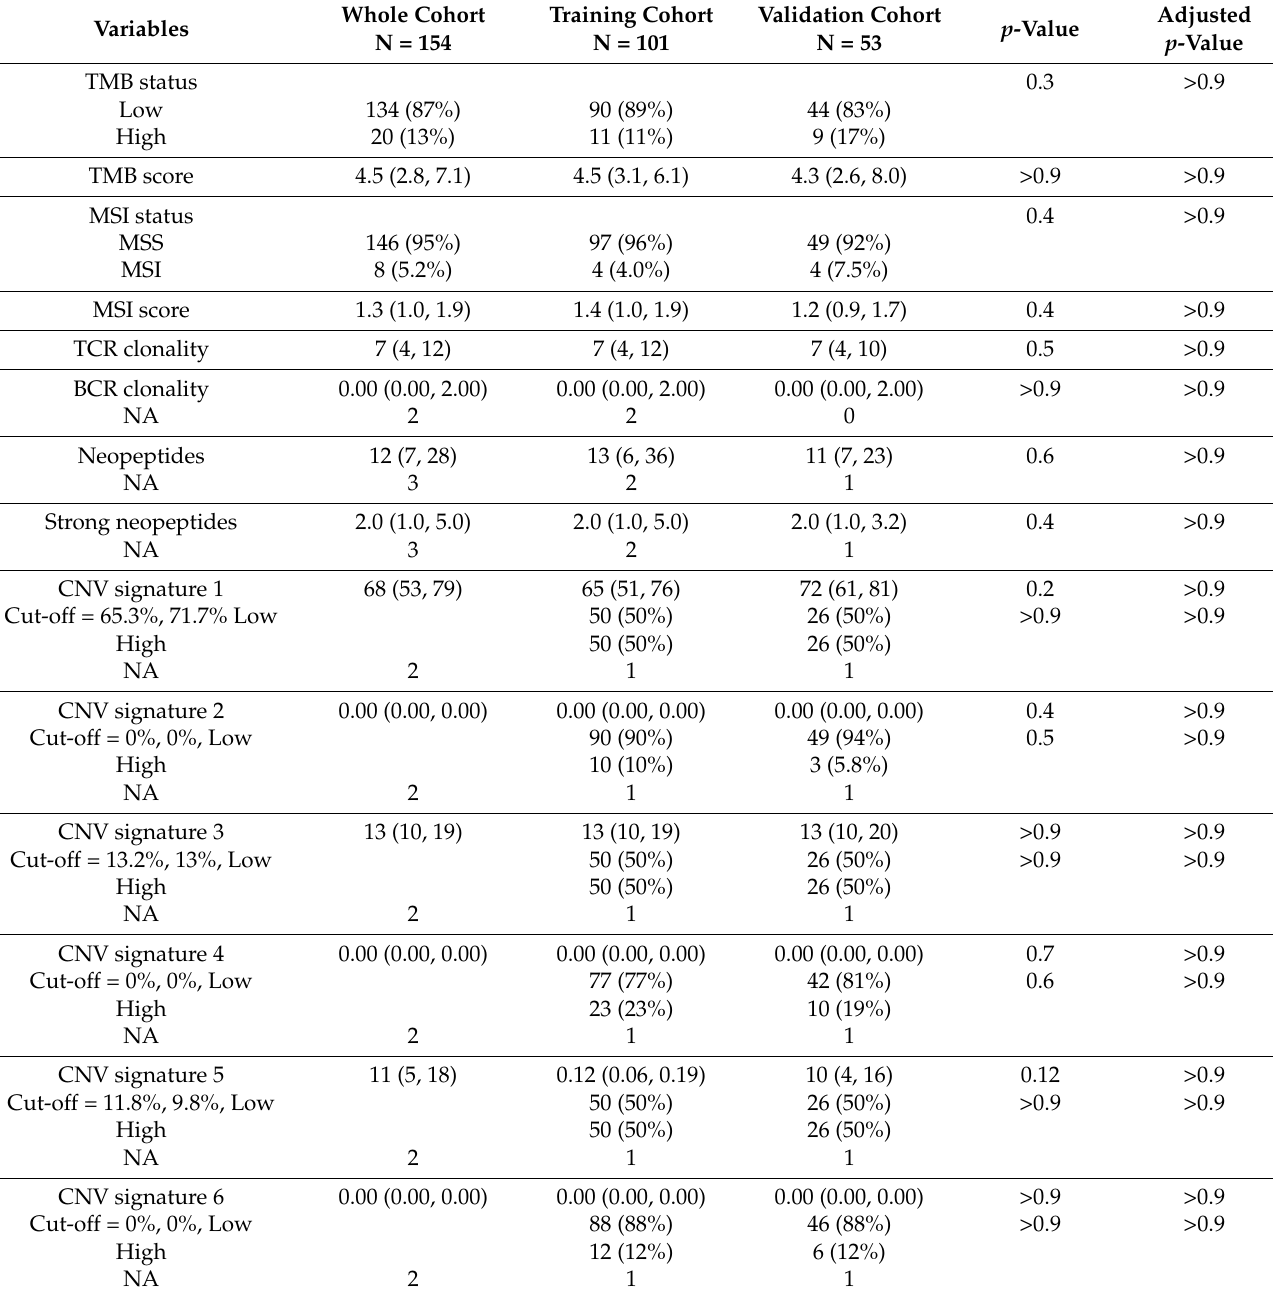
Figure 1. Genomic landscape of genes associated with response to immune checkpoint inhibitors. Tumor samples are sorted by cancer type and ascending order for TMB score. TMB: Tumor Mutational Burden, TCR: T-Cell Receptor. Table 2. Exome-derived variables for the whole cohort and the training and validation